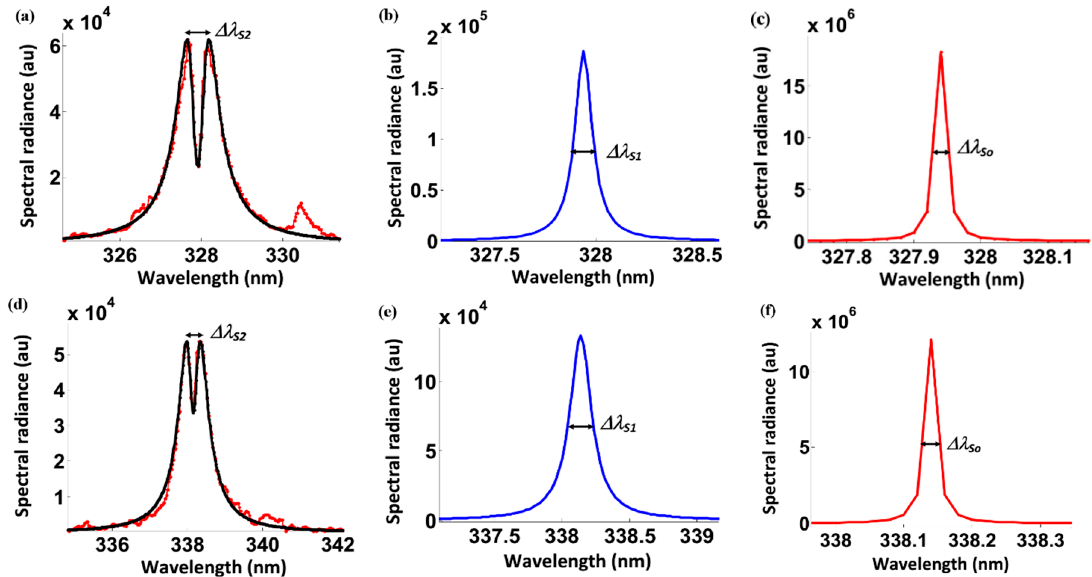
Figure 8. Line shapes ( a ) self-reversed Δλ S2 = 0.37 nm, SR = 0.3, T( λ ) = 33%; ( b ) Self-absorbed Δλ S1 = 0.2 nm, n e1 = 4.2 × 10 18 cm − 3 , SA = 0.01; ( c ) Reconstructed 327.9-nm optically thin line: Δλ S0 = 0.017 nm, n e1 = 3.5 × 10 17 cm − 3 , SA = 1. ( d ) Δλ S2 = 0.32 nm, SR = 0.38, T( λ ) =40%, ( e ) Δλ S1 = 0.19 nm, SA = 0.01, and ( f ) 338.2-nm line: Δλ S0 = 0.017 nm, n e1 = 3.5 × 10 17 cm − 3 , SA = 1. Light pulses for ( a ) and ( d ) of fluence 13.5 J/cm 2 at 355 nm generated laser plasma. Reconstruction for ( c ) and ( f ) is accomplished with data from the 827-nm line.